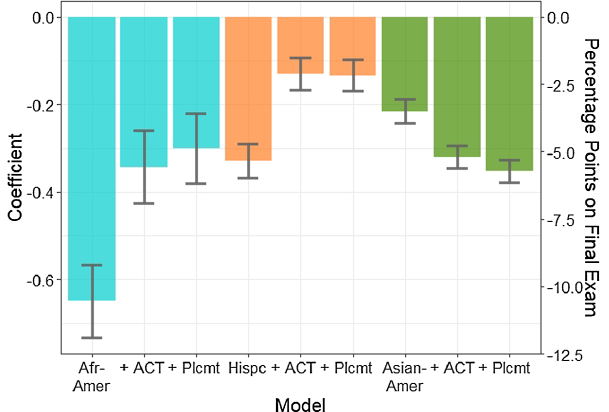
FIG. 2. Multiple linear regression coefficients from the differ- entiated models reported in Table V. Coefficients represent the standardized difference in final exam performance between non- Hispanic White American students and the specified group. The error bars represent the standard error for each coefficient. The coefficients had p < 0 . 001 for all three models.